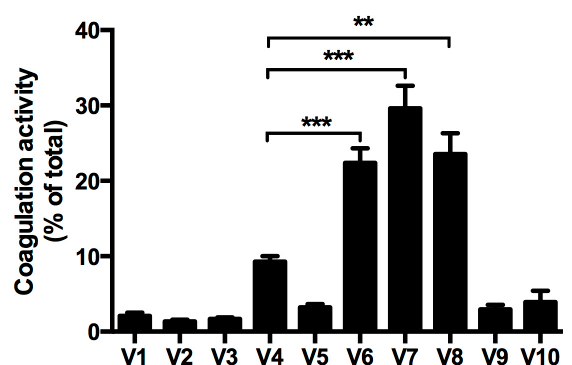
Figure 4. Procoagulant activity in the density gradient sub-fractions of the (V)LDL precipitate. V1, the first sub-fraction of (V)LDL precipitate separated by density gradient centrifugation. The coagulation activity of each sub-fraction was determined by Factor Xa generation and expressed as percentage relative to total coagulation activity. Four independent experiments were performed.